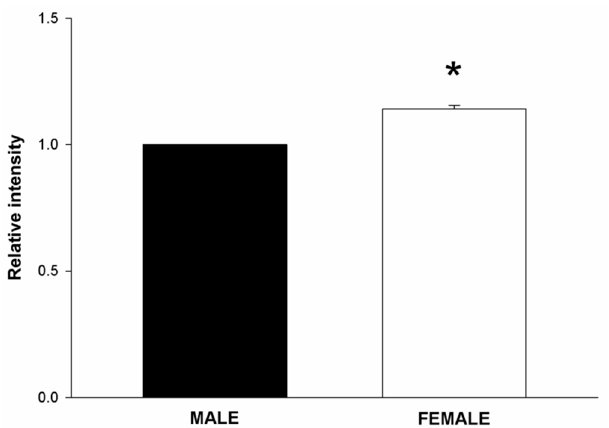
Figure 2. H 2 O 2 level in cells derived from male and female rat thyroid. The level of H 2 O 2 was evaluated by Premo ™ cellular hydrogen peroxide sensor and was expressed relative to the male group. Bars represent the mean ± SE of three independent experiments. * p < 0.05.